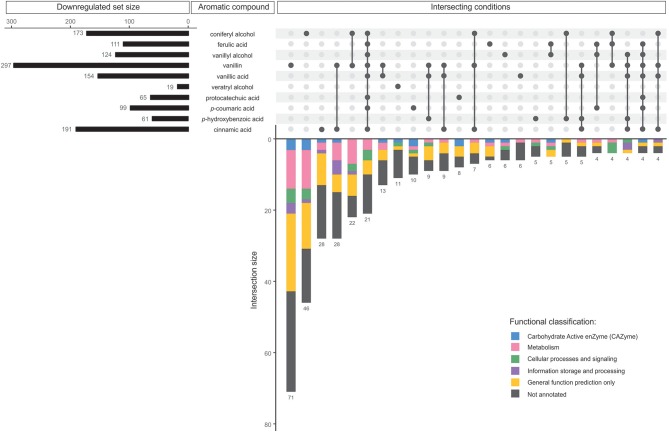
Comparative analysis of all downregulated genes in D. squalens grown in the presence of aromatic compounds. The horizontal bars represent the total number of genes identified as downregulated on the individual aromatic compounds. The vertical bars or intersections represent the number of genes that were regulated by one or more aromatic compounds (intersecting conditions). The intersections were organized by size and top 25 sets with the highest number of genes were presented. The genes in each intersection were color-coded according to their functional classification.